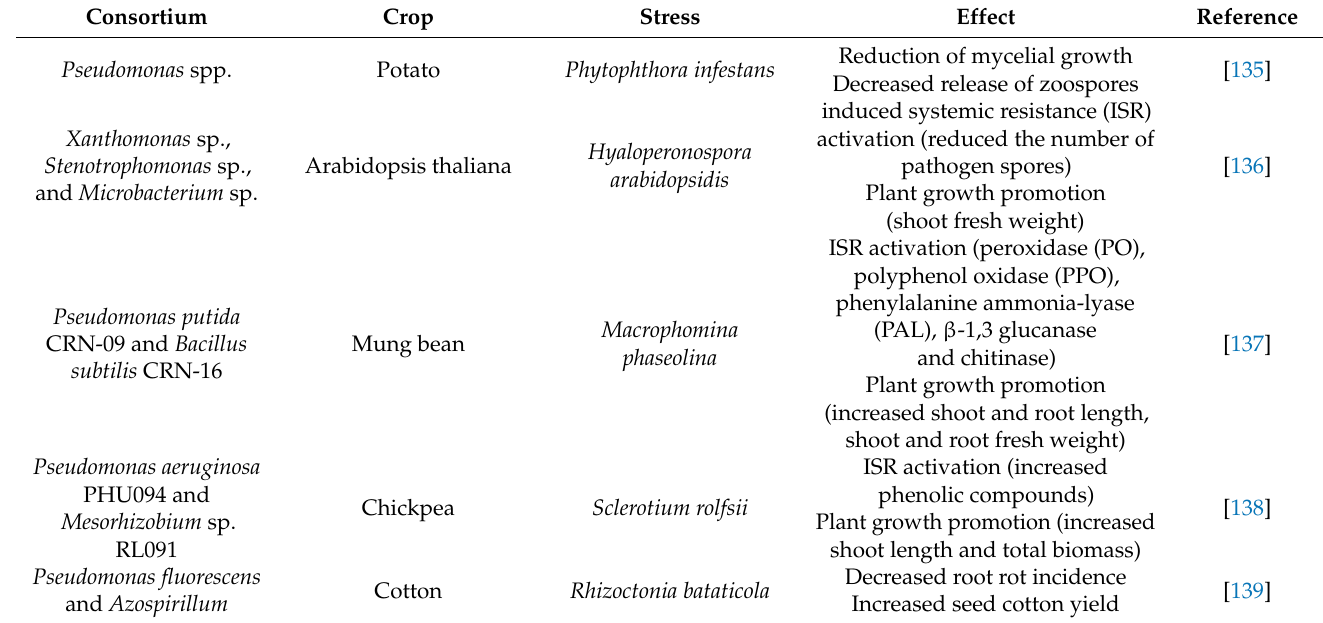
Table 2. Examples of bacterial consortia and their beneficial effects on crop plants under biotic and abiotic stresses. Consortium Crop Stress Effect Reference Pseudomonas